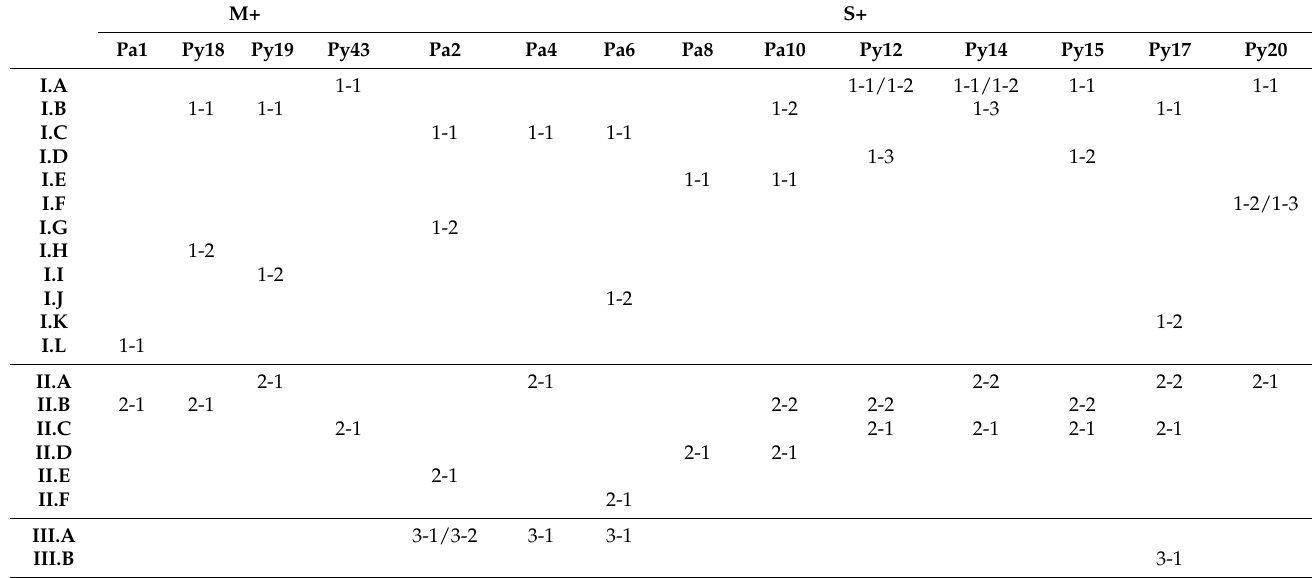
Table 2. Molecular variants composition of grapevine fanleaf virus in individual ‘Chardonnay’ vines and their classification in phylogenetic clades (Figure 5). The clade names are ‘I’ for ORF1, ‘II’ for ORF2 and ‘III’ for ORF3. The number of molecular variants is indicated. When two molecular variants affiliated to a same clade are present in a vine, their numbers are separated by a